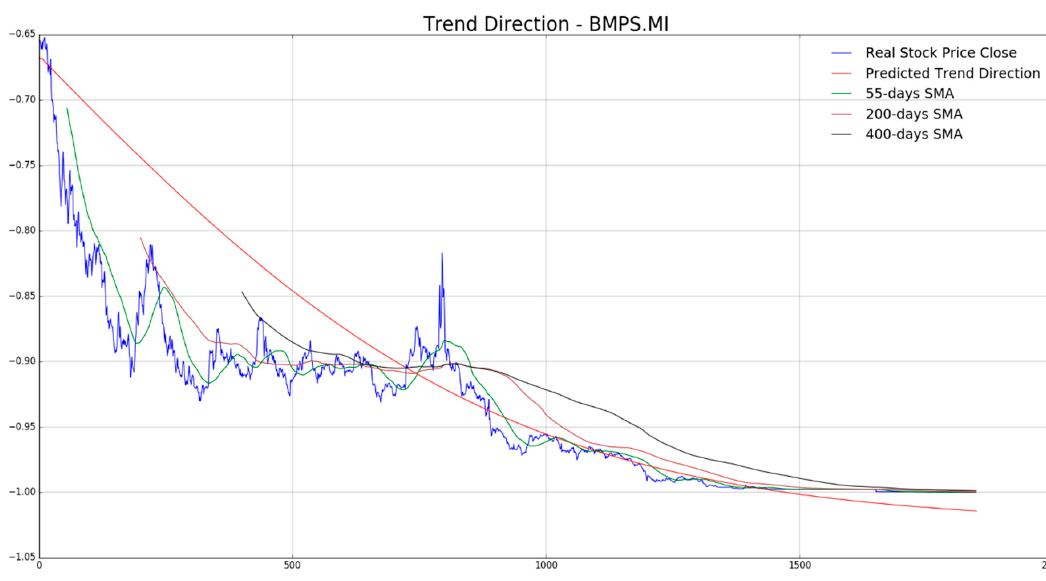
Figure 8. BMPS.MI Trend Direction (red) and SMA.